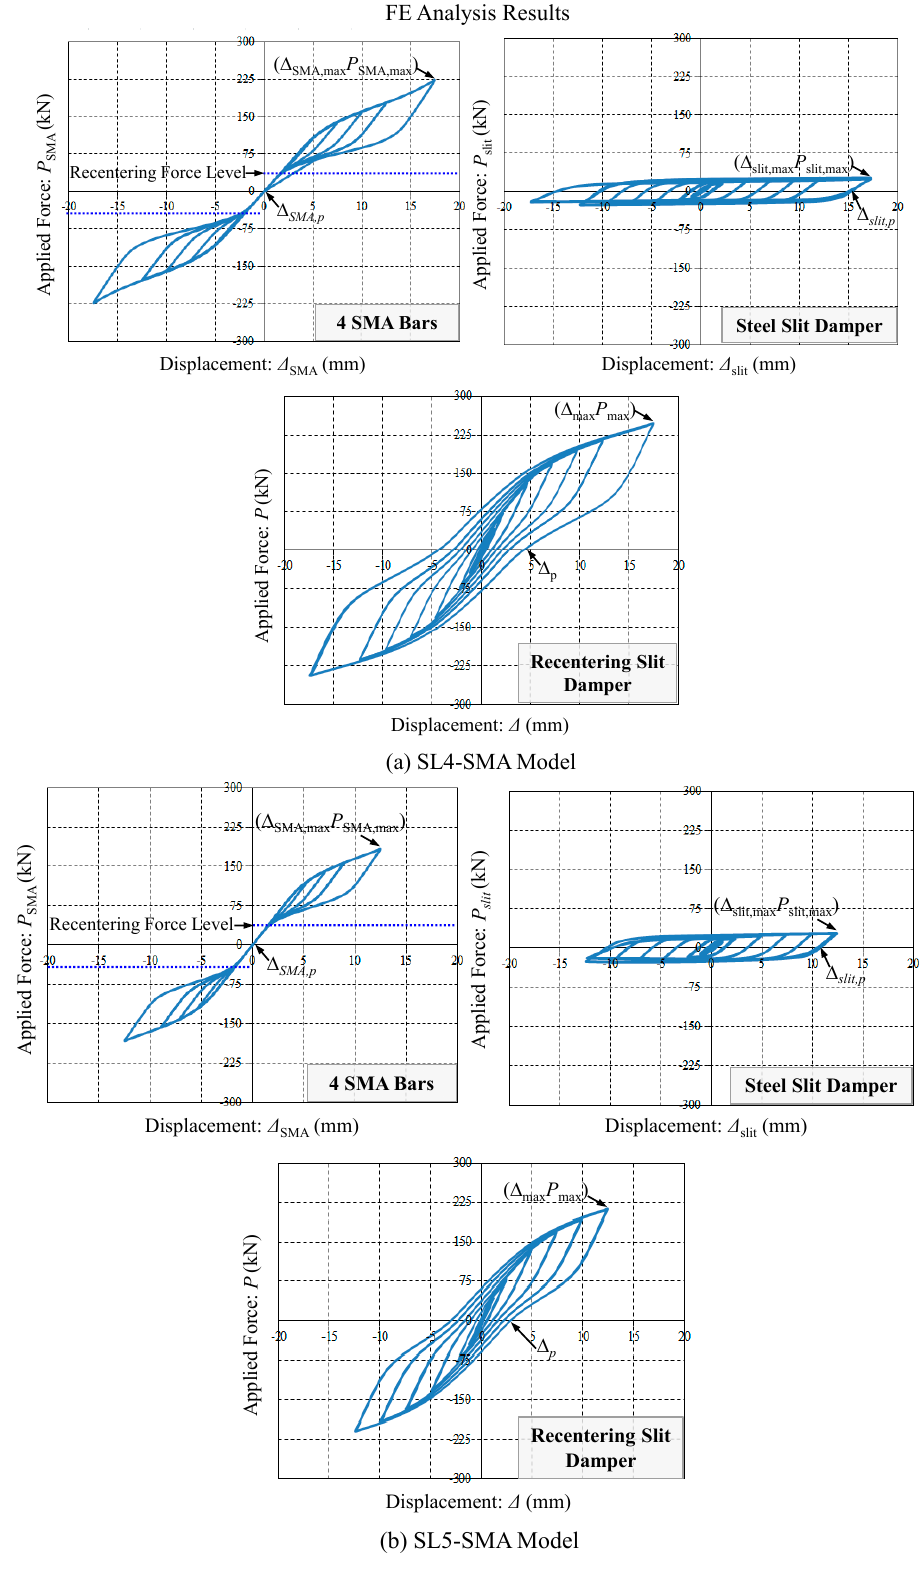
Figure 12. Simulated curves for the behavior of individual components (4 SMA bars and steel slit damper) and the total behavior of the recentering slit damper systems, ( a ): SL4-Model and ( b ): SL-5